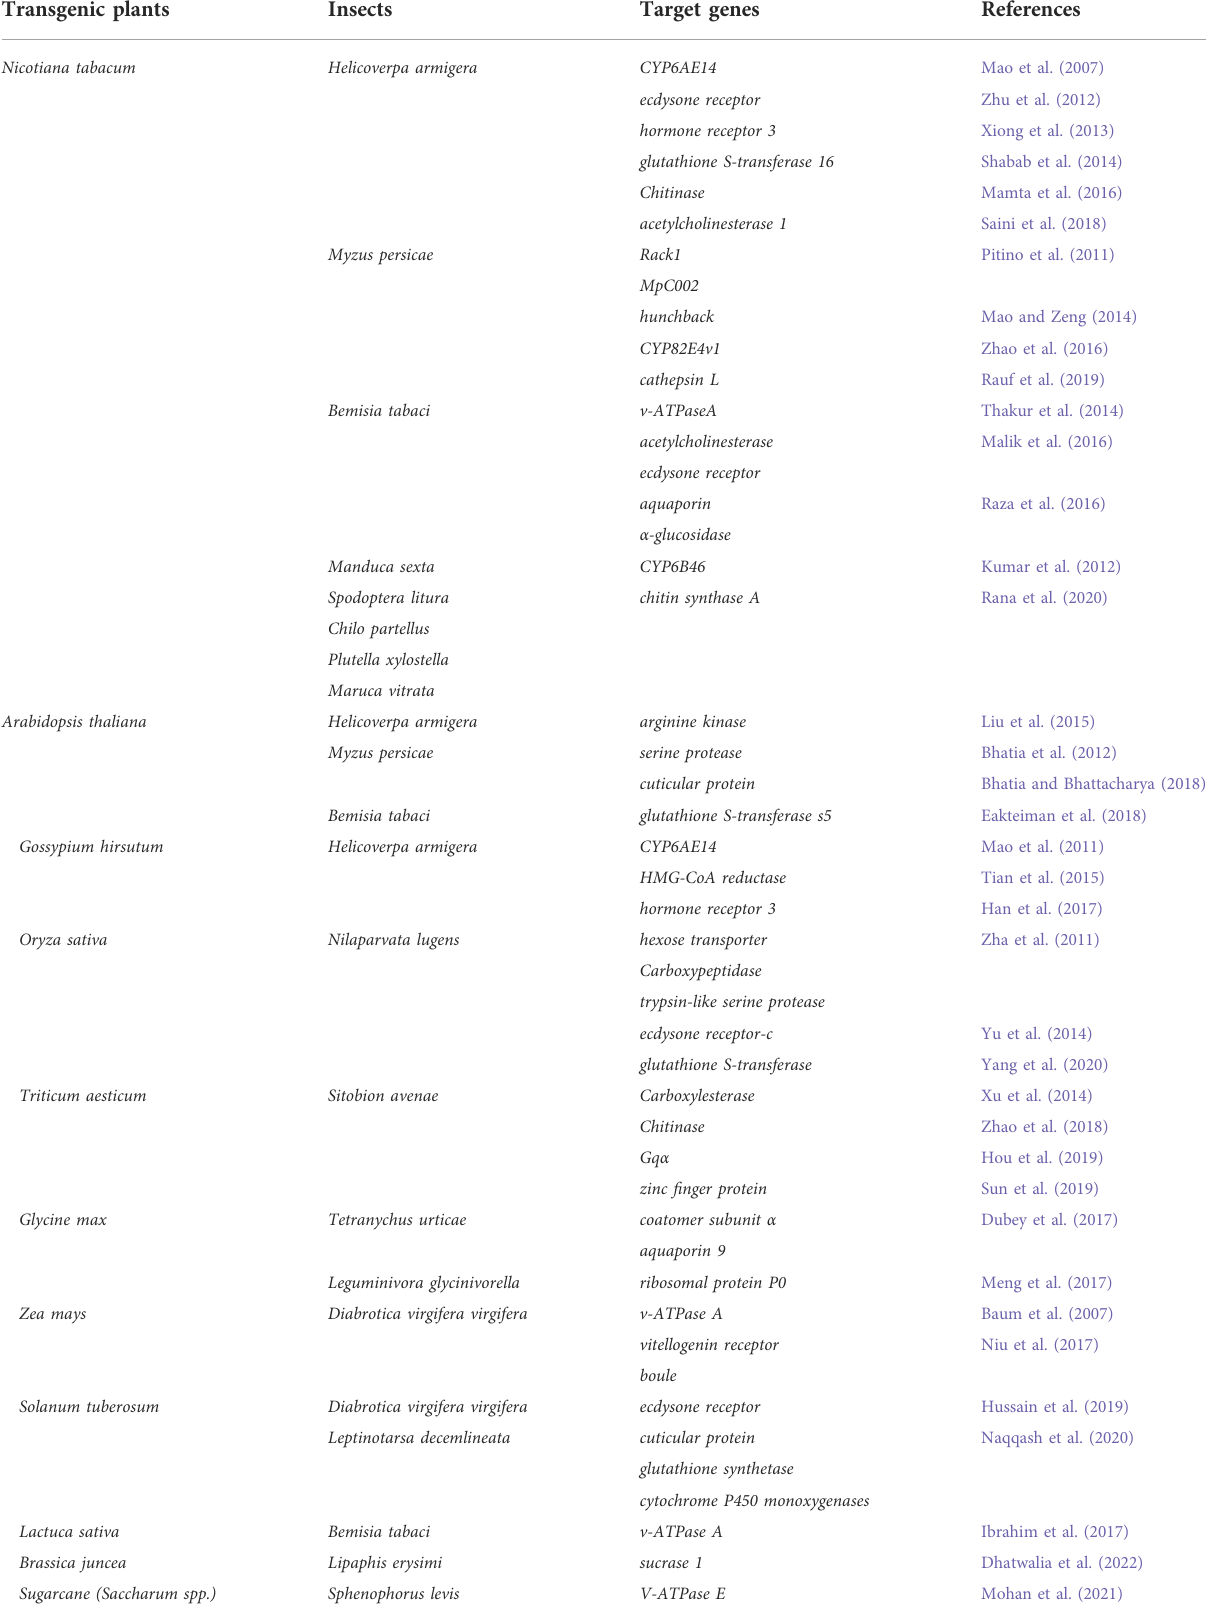
TABLE 1 Nuclear transformation-mediated dsRNA-expressing transgenic plants in pest